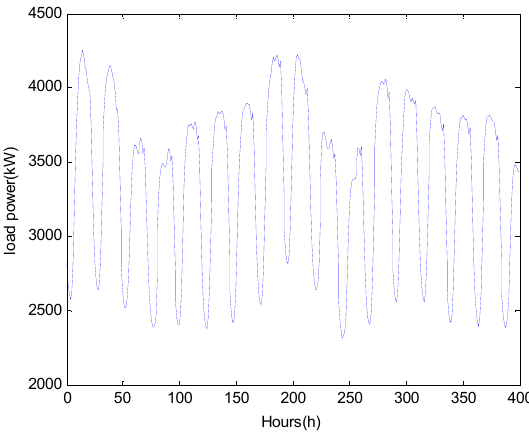
Figure 6. The power load data of August 2013.